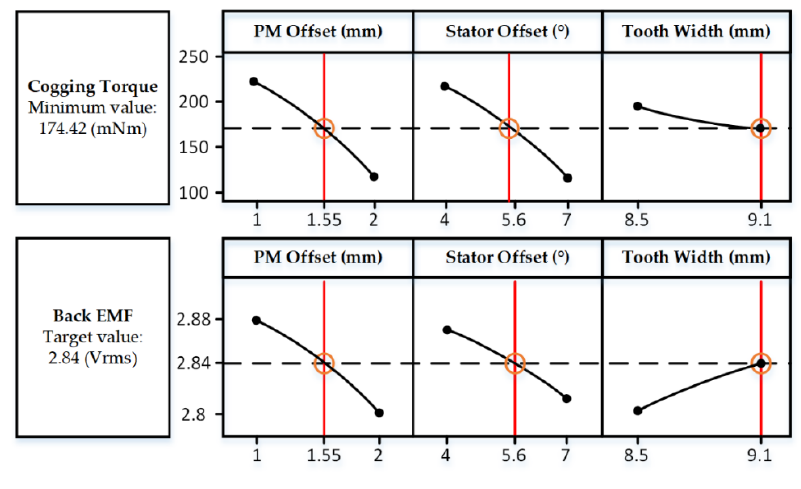
Figure 9. Set optimal point based on the initial parameter.